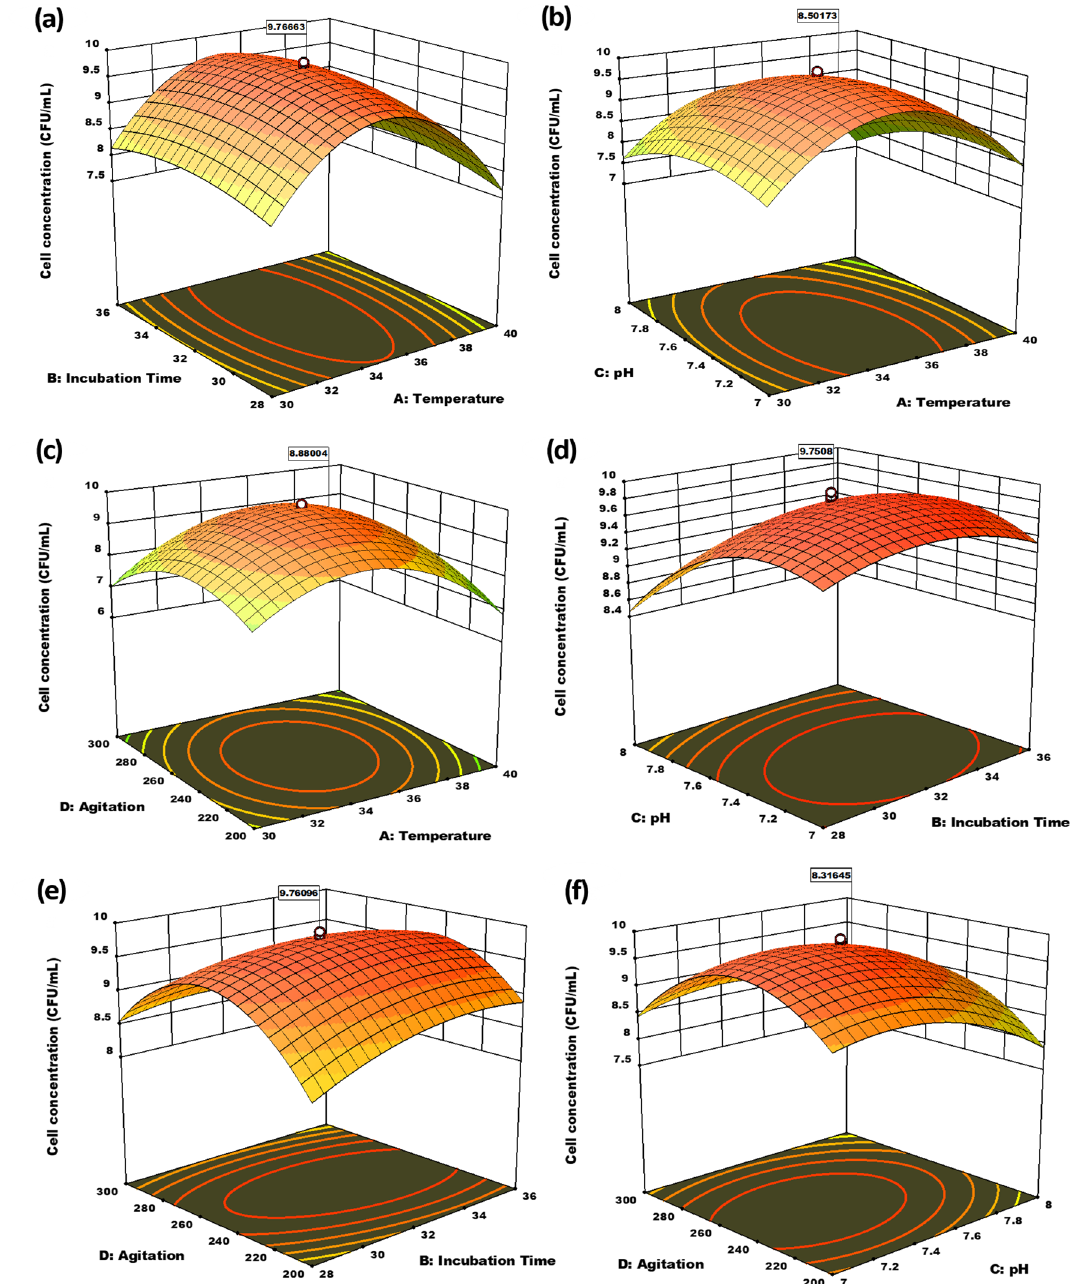
Incubation time and pH. ( e ) Incubation time and agitation. ( f ) pH and